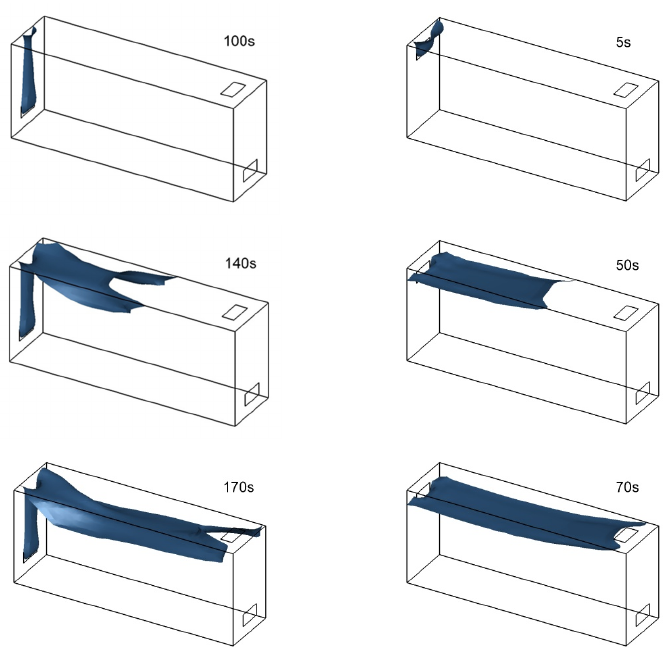
Figure 6. Iso-surface of 4% hydrogen mole fraction for Model 4 (left) and Model 5 (right).